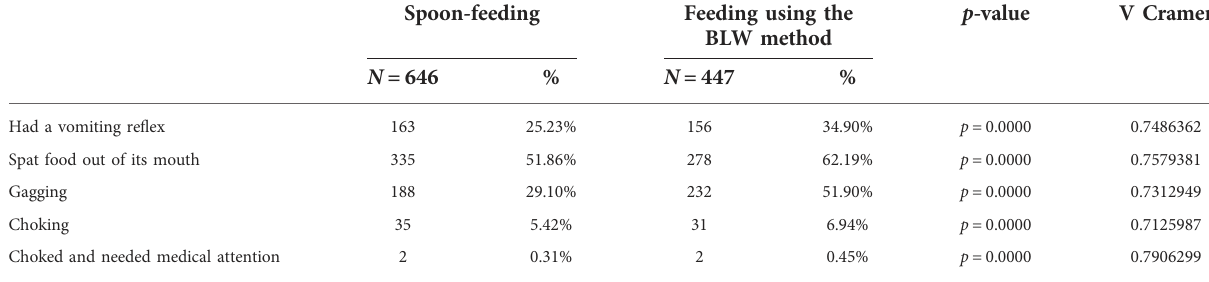
TABLE 7 Comparison of incidents during spoon-feeding vs BLW eating ( N =646) - sum of responses is greater than 100%. Spoon-feeding Feeding using the BLW